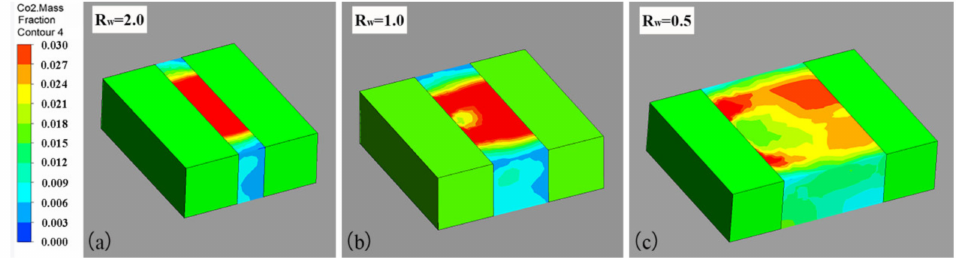
Figure 10. Contours of street ventilation surfaces with different aspect ratios: ( a ) R w = 2.0; ( b ) R w = 1.0; ( c ) R w =